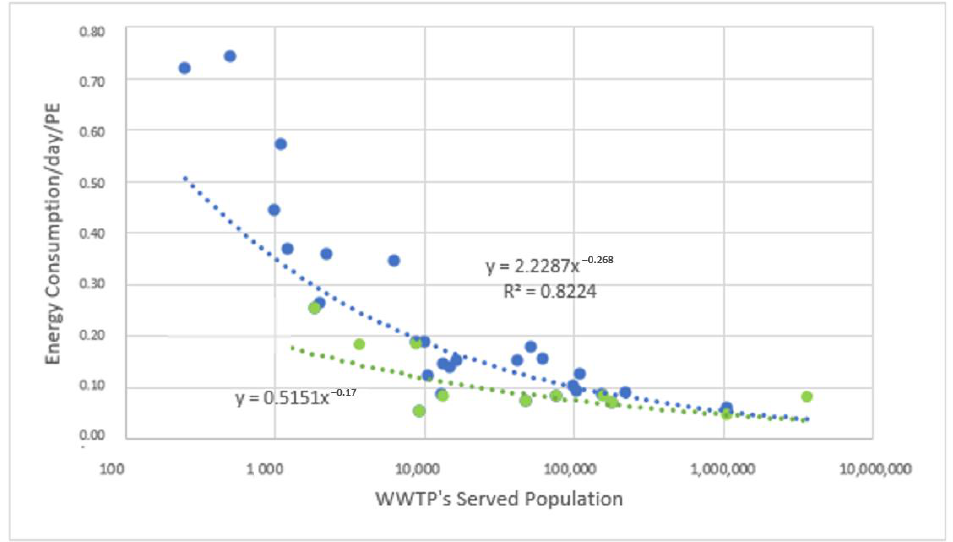
Figure 3. WWTP Energy Consumption by Population Served.